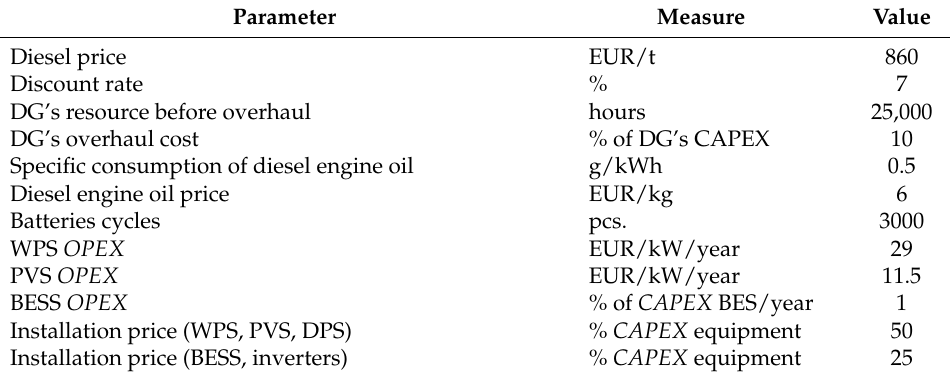
Table 5. Basic economic parameters of the